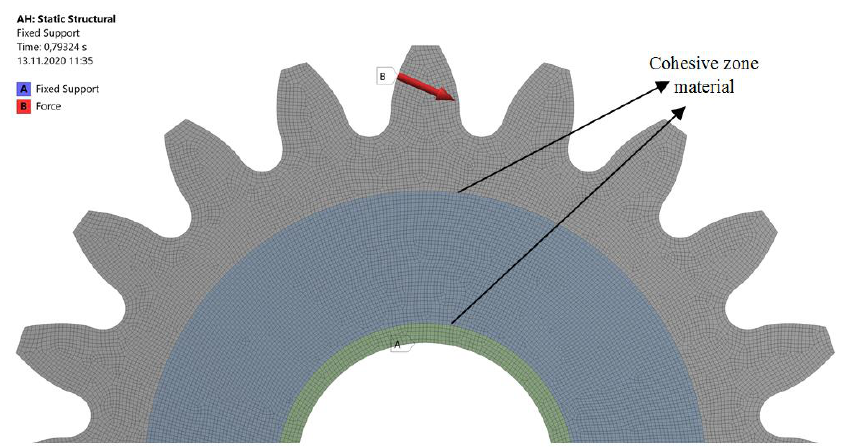
Figure 3. The load and support